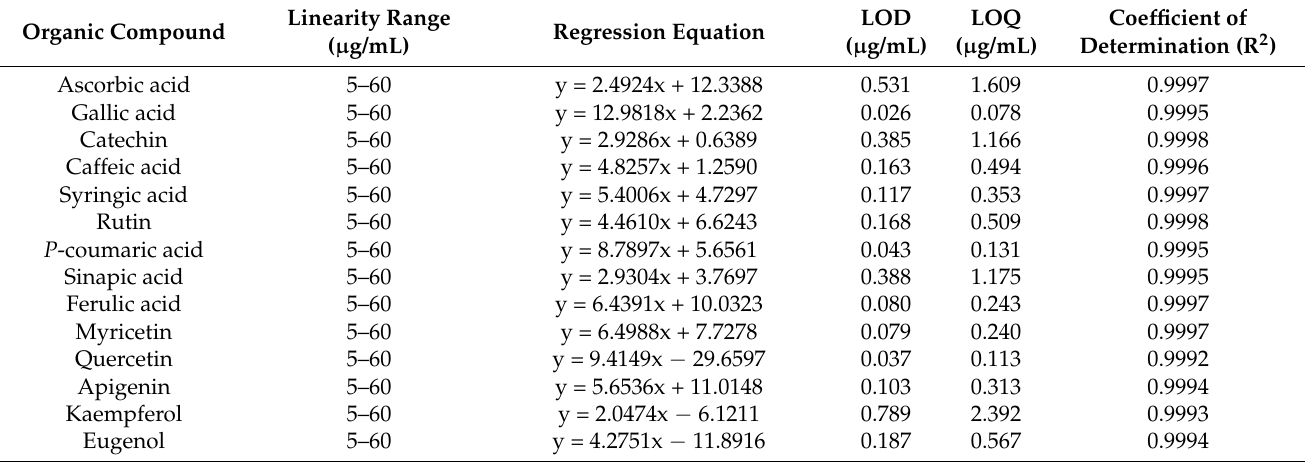
Table 1. Calibration curve, selectivity, linearity, and limit of detection (LOD) and quantification (LOQ) parameters. Organic Compound